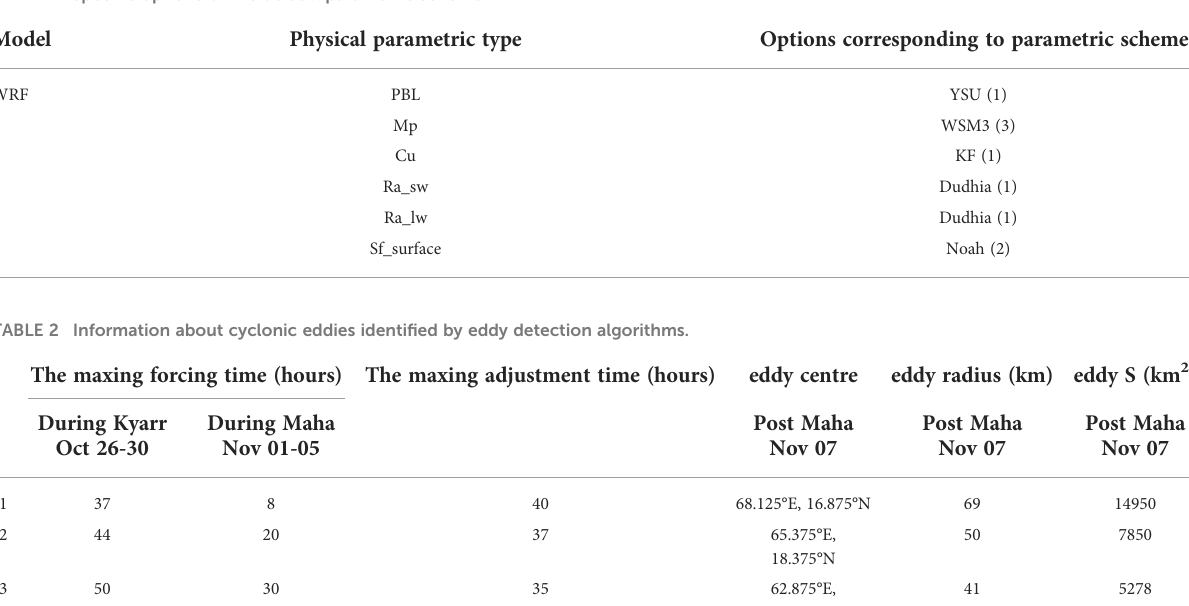
TABLE 1 Speci fi c options of the default parametric